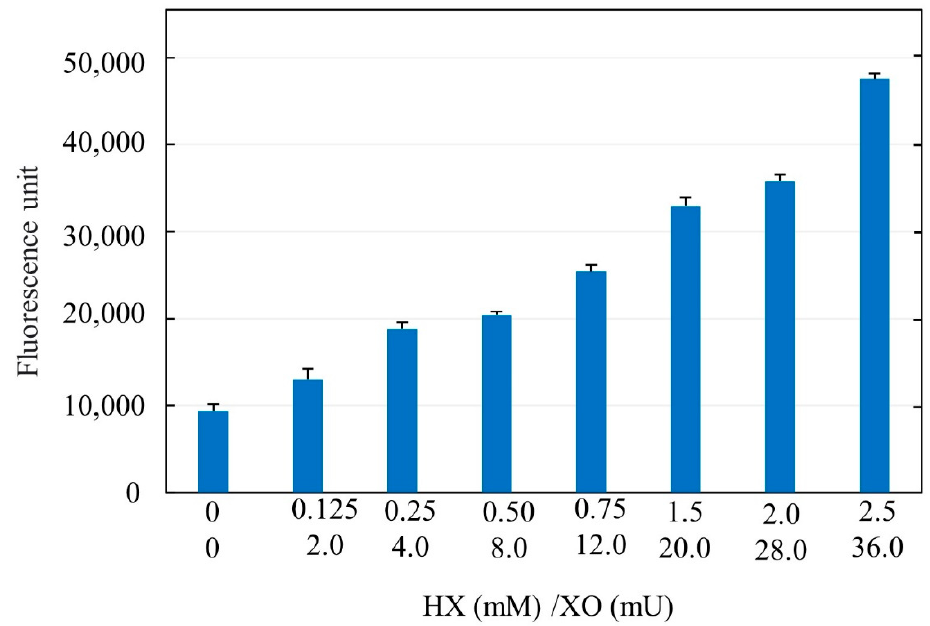
Figure 5. Dose-dependent generation of fluorescent ROS, as assessed by the DCFH method. The results are the means ± SD of triplicate analyses and are expressed as arbitrary fluorescence units.